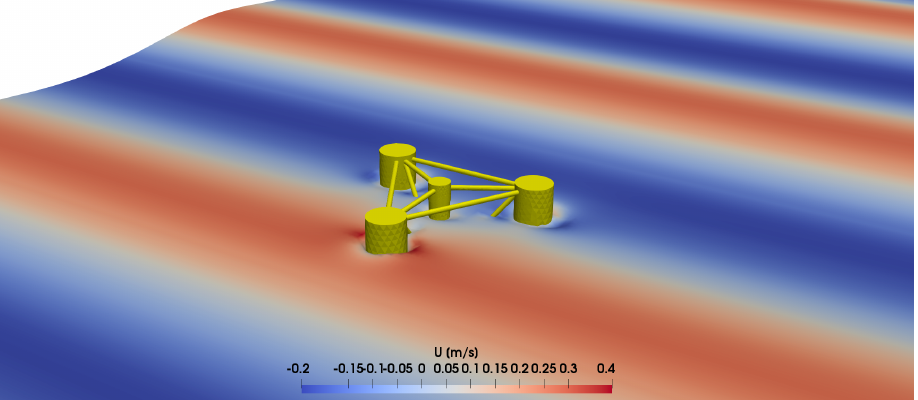
Figure 17. Illustration of the support structure facing a wave crest. The contour shows the free surface, and the colours indicate the velocities in x